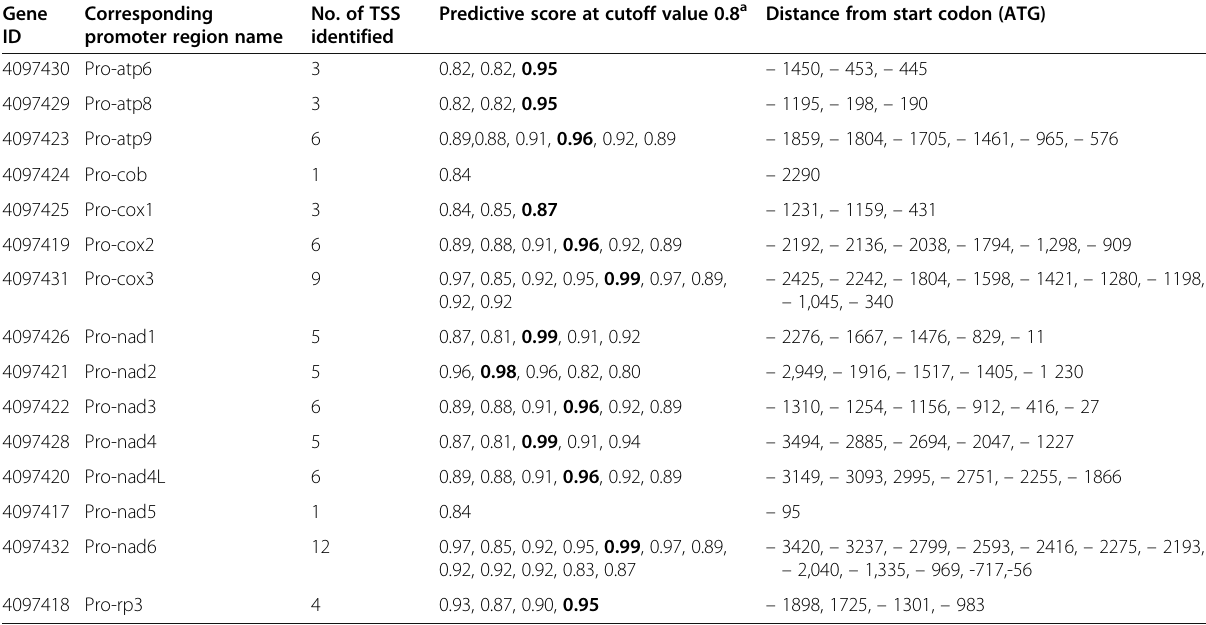
Table 1 Predictive cutoff score and number of transcription start site for the corresponding genes Gene Corresponding ID promoter region name